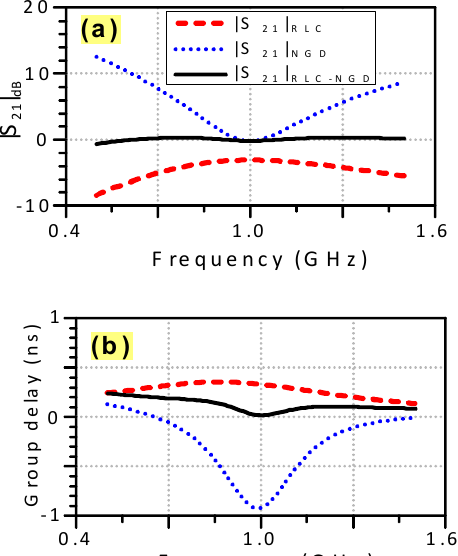
Figure 7: Transmission parameters of the circuit presented in Fig. 6. (a) Magnitude and (b) group delay.